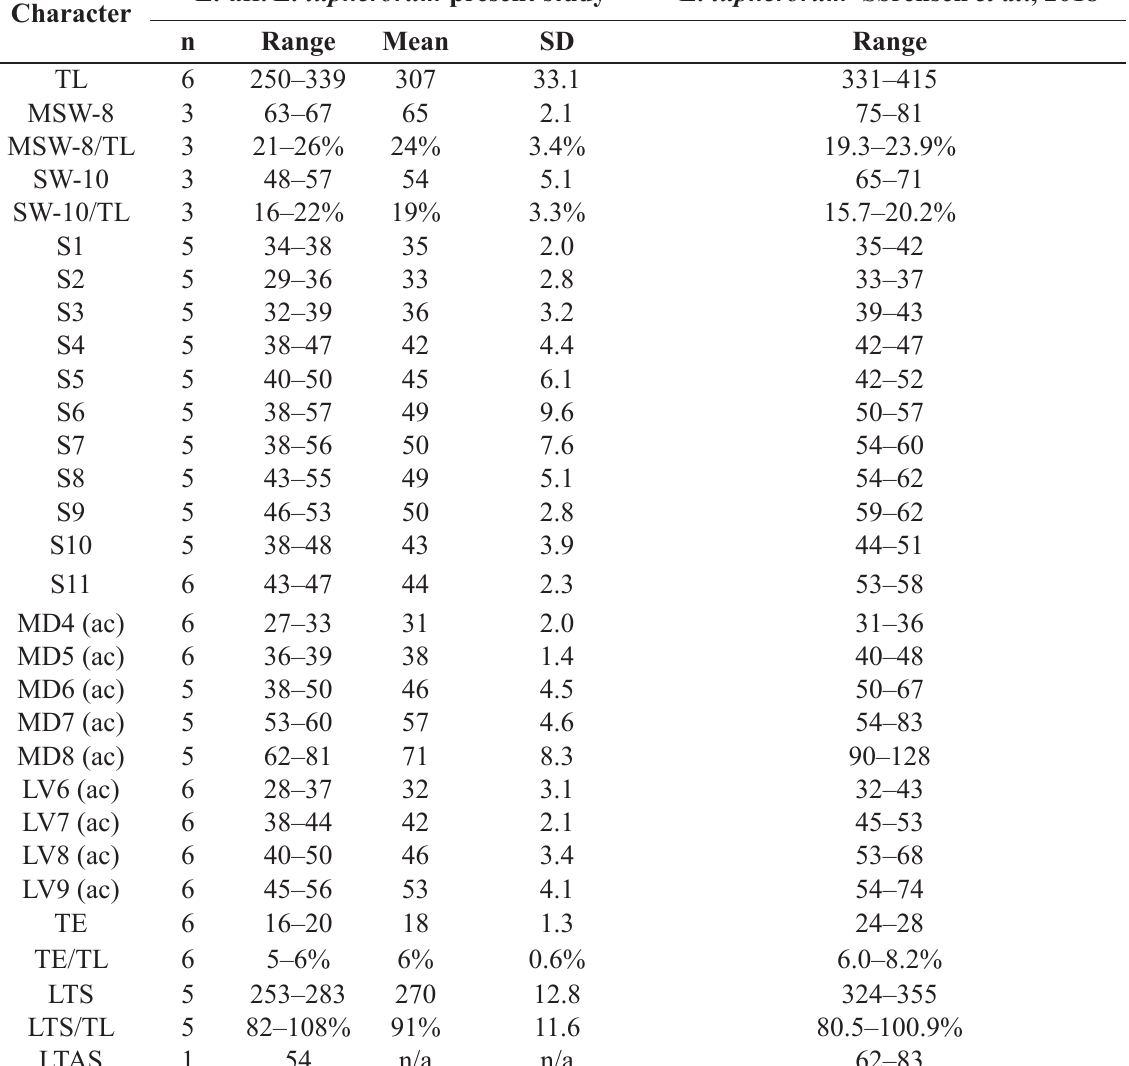
Table 24. Measurements from light microscopy of Echinoderes sp. aff. E. lupherorum (in µm) from the Hikurangi Margin with comparison of measurements for E. lupherorum from its type locality, including number of measured specimens (n) and standard deviation